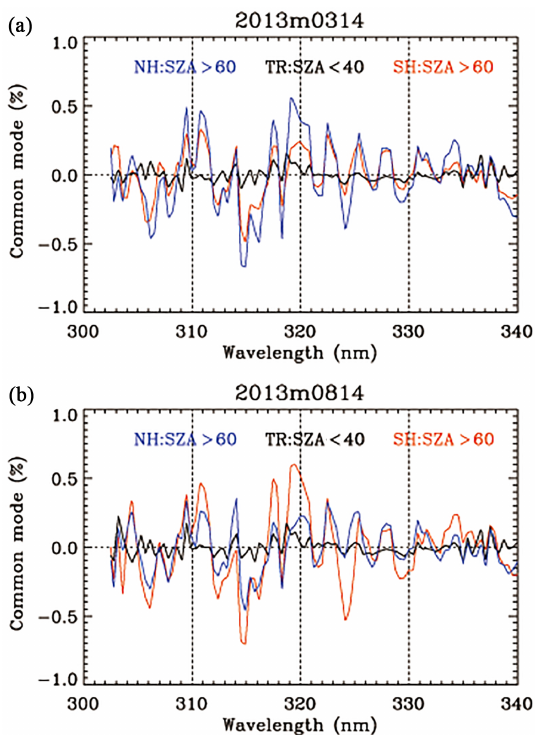
Figure 9. Common mode spectra derived from final fitting residu- als at the 17th cross-track position using 1 day of measurements in March (a) and August (b) , respectively. Note that tropical residuals are derived from near-clear-sky conditions where SZA<40 ◦ , cloud fraction <0.1 and surface albedo <0.1. No special data screening is applied for polar residual spectra, except for SZA >60 ◦